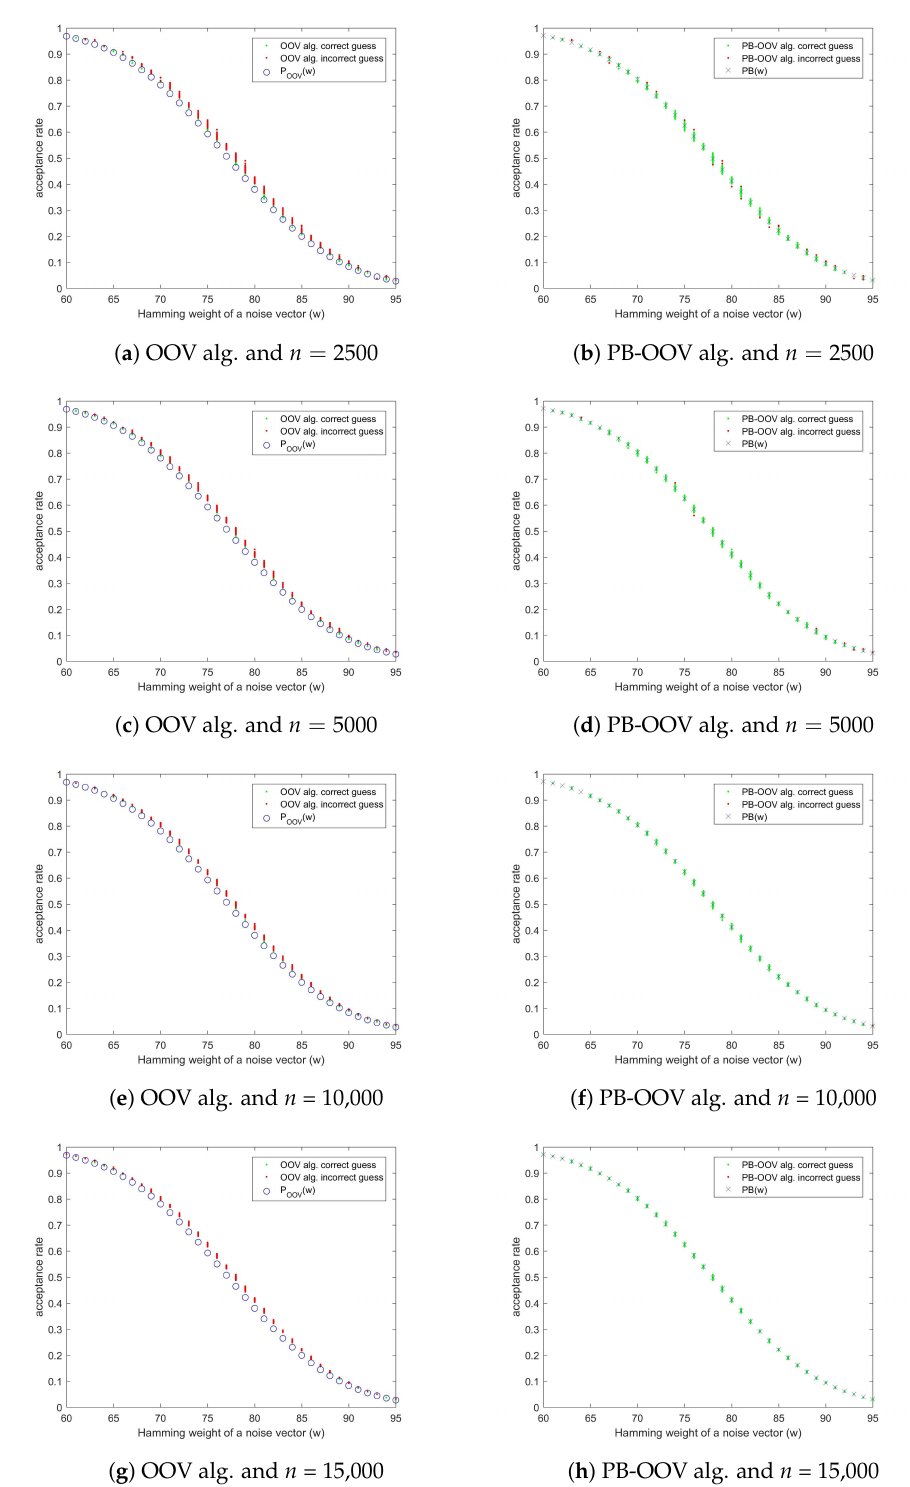
Figure 11. Comparison of the experimentally obtained acceptance rates and the corresponding P OOV ( (cid:107) e i (cid:107) ) and PB ( (cid:107) e i (cid:107) ) points for n = 2500, 5000, 10,000,